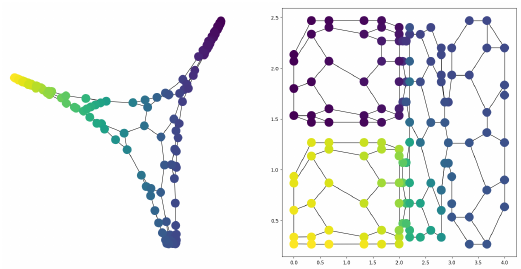
Figure 6. Spectral embedding (left) and dual embedding (right) of G , coloured according to Fiedler vector x 2 .